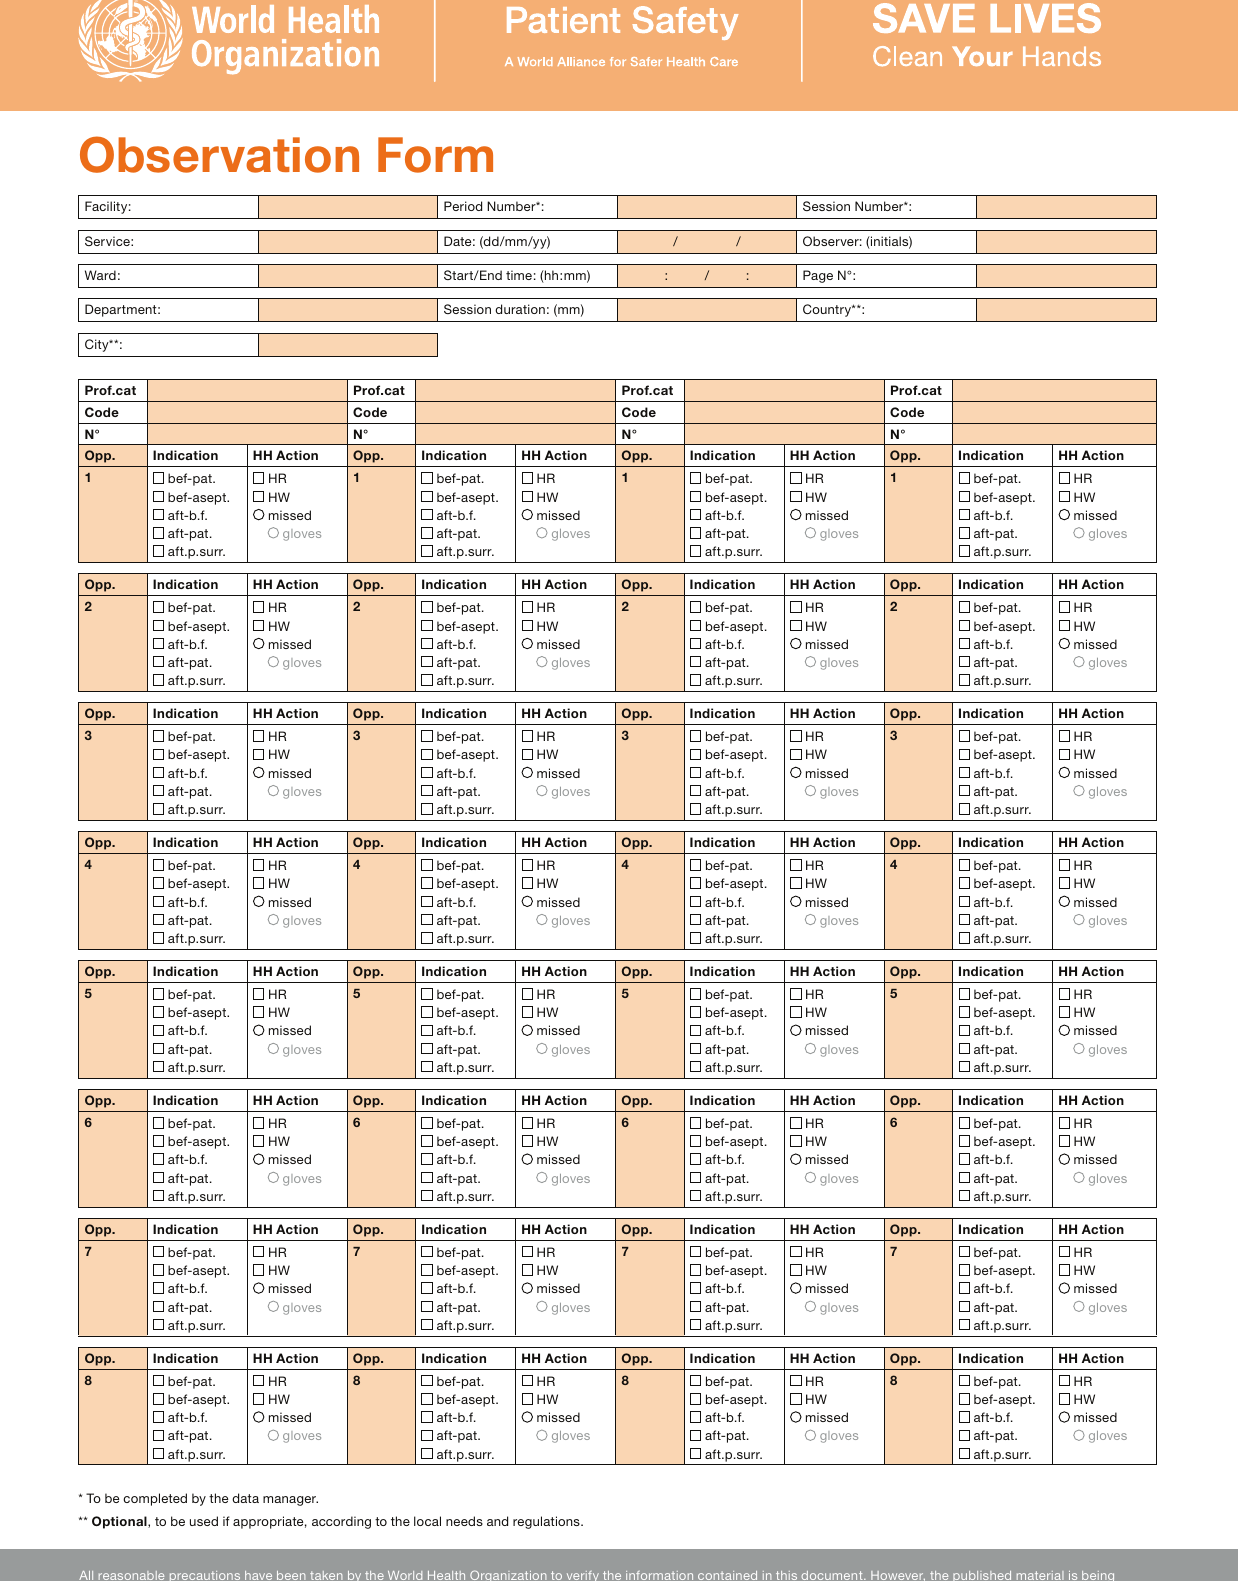
HR HW missed gloves HR HW missed gloves HR HW missed gloves HR HW missed gloves HR HW missed gloves